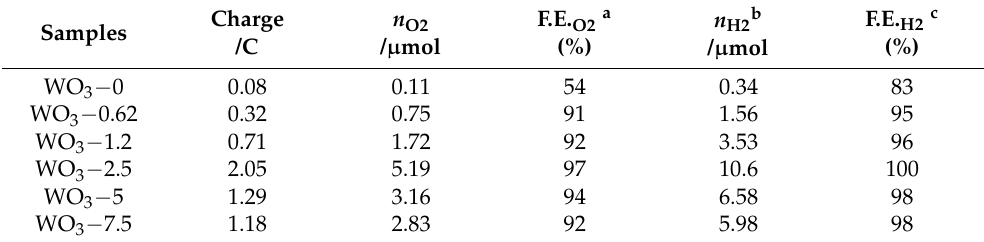
Figure 11. Photocurrent density versus time profiles during PEC water oxidation in a 0.1m phosphate buffer solution of pH 6.0 at 0.68 V vs. Ag/AgCl (1.23 V vs. RHE) upon visible-light irradiation ( λ > 450 nm, 100 mWcm − 2 ) using (a) WO 3 − 0, (b) WO 3 − 0.62, (c) WO 3 − 1.2, (d) WO 3 − 2.5, (e) WO 3 − 5, and (f) WO 3 − 7.5 electrodes. Table 3. Summary of PEC water oxidation in a 0.1 M phosphate buffer solution (pH 6.0) for 1 h using different WO 3 electrodes calcined at 420 ◦